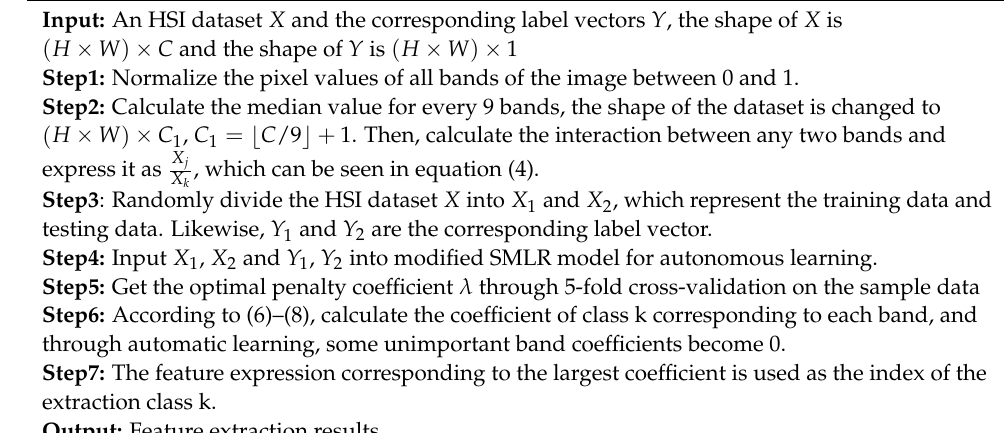
Algorithm 1 The modified SMLR model for autonomous learning